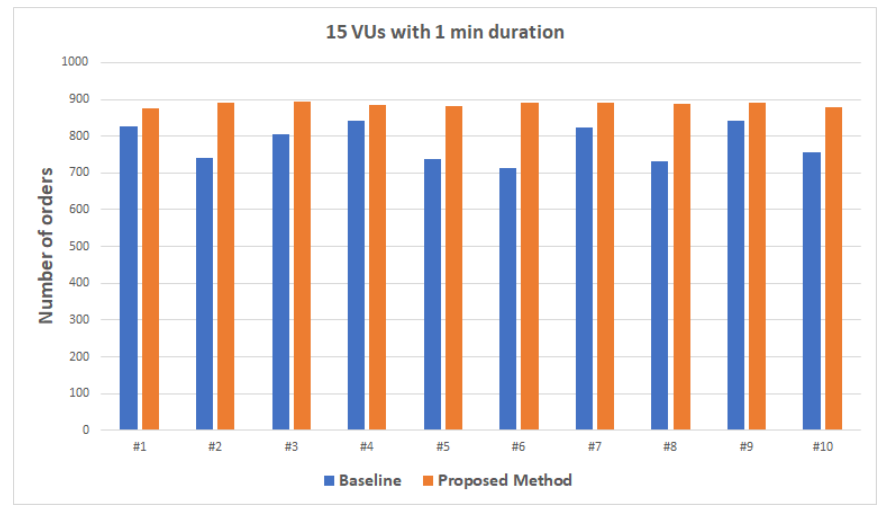
Figure 15. Load Testing—15 virtual users with 1 min duration.